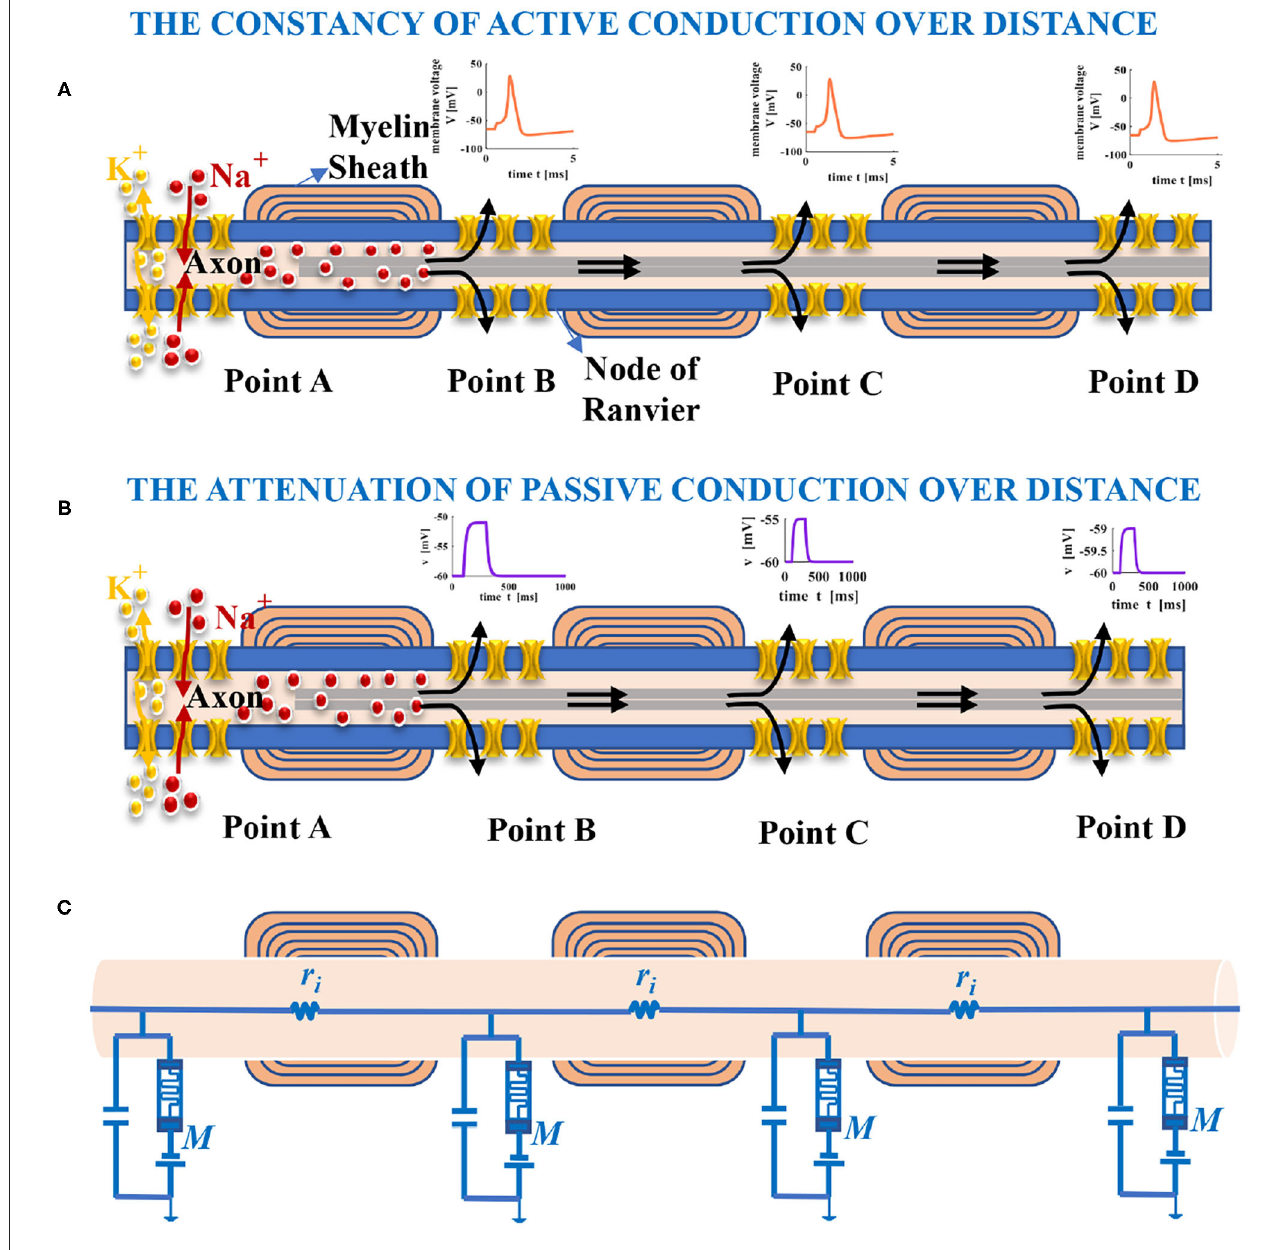
FIGURE 5 | Long-distance propagation of spikes in the axon. (A) The action potential with constant amplitude yielded by the external current pulse, which spreads with increasing distance (the black arrows show the conduction direction of current). (B) The amplitude of membrane potential decreases with the distance increase because the injected current leaks out of the axon. (C) An electrical circuit model of the axon in